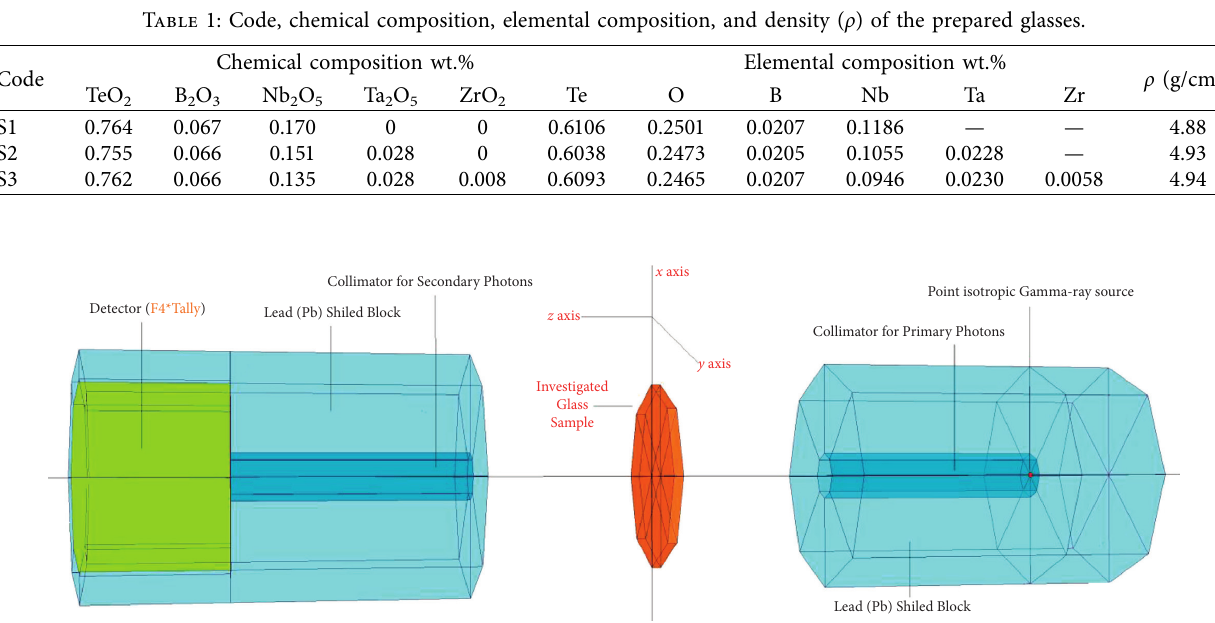
Figure 1: 3D view of the MCNPX simulation setup utilized for gamma-ray transmission simulations (obtained from the MCNPX visual editor